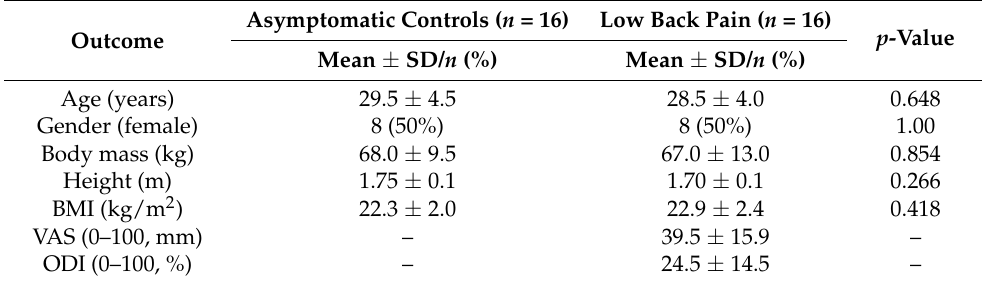
Table 1. Demographic and clinical characteristics of the sample. Asymptomatic Controls ( n = Outcome